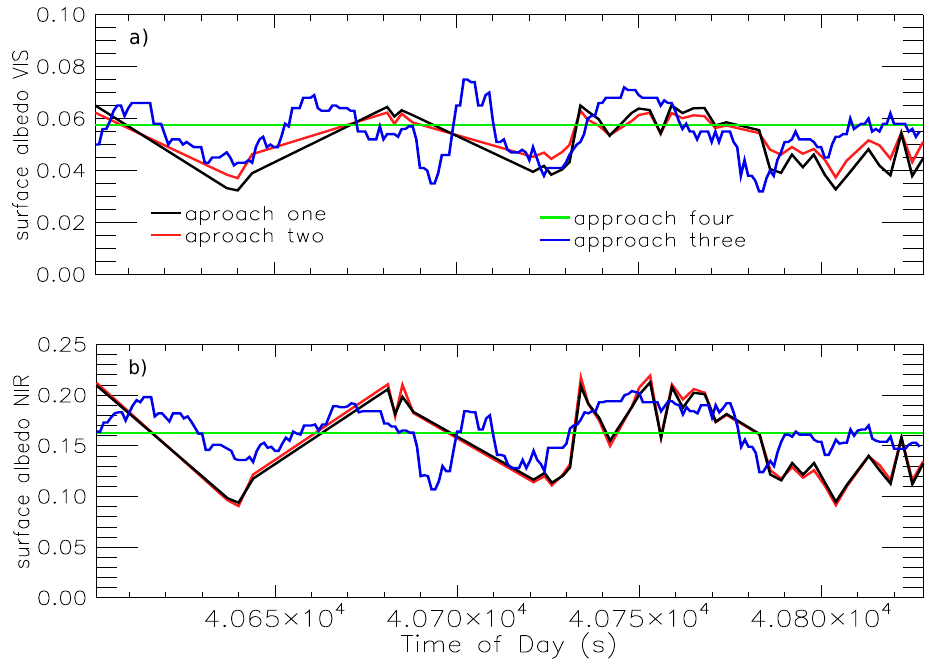
Fig. 13. (a) VIS surface albedo of time series corresponding to retrieval of 4 November. (b) NIR surface albedo of time series corresponding to retrieval of 4 November. Time is given in